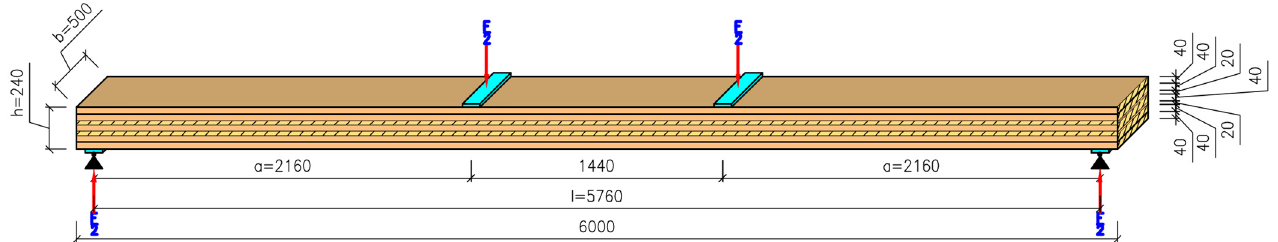
Figure 3. Test arrangement and geometry of CLT 160-5.